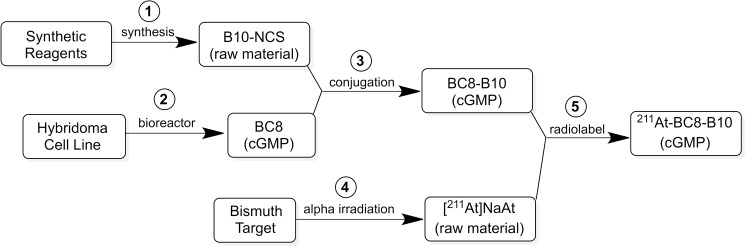
Scheme depicting the five production steps in the cGMP production of 211At-BC8-B10.Each of the products were isolated, purified and characterized. The product from each step had to meet preset release criteria prior to being used in the next step.